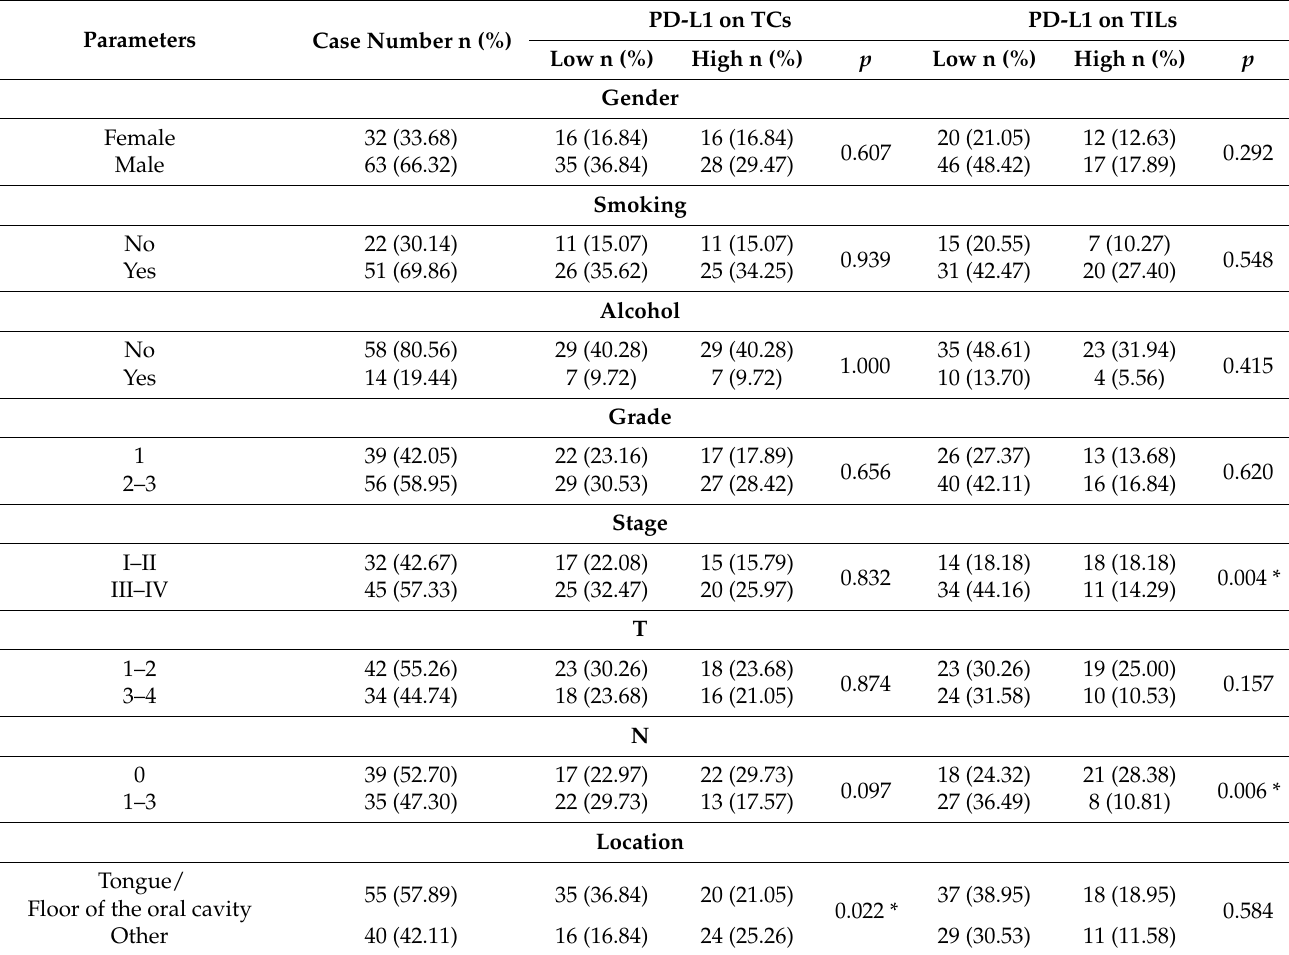
Table 1. The summary of clinicopathological features with relation to PD-L1 expression on TCs and TILs ( p — p value; *—statistically significant p ). p values were calculated with chi